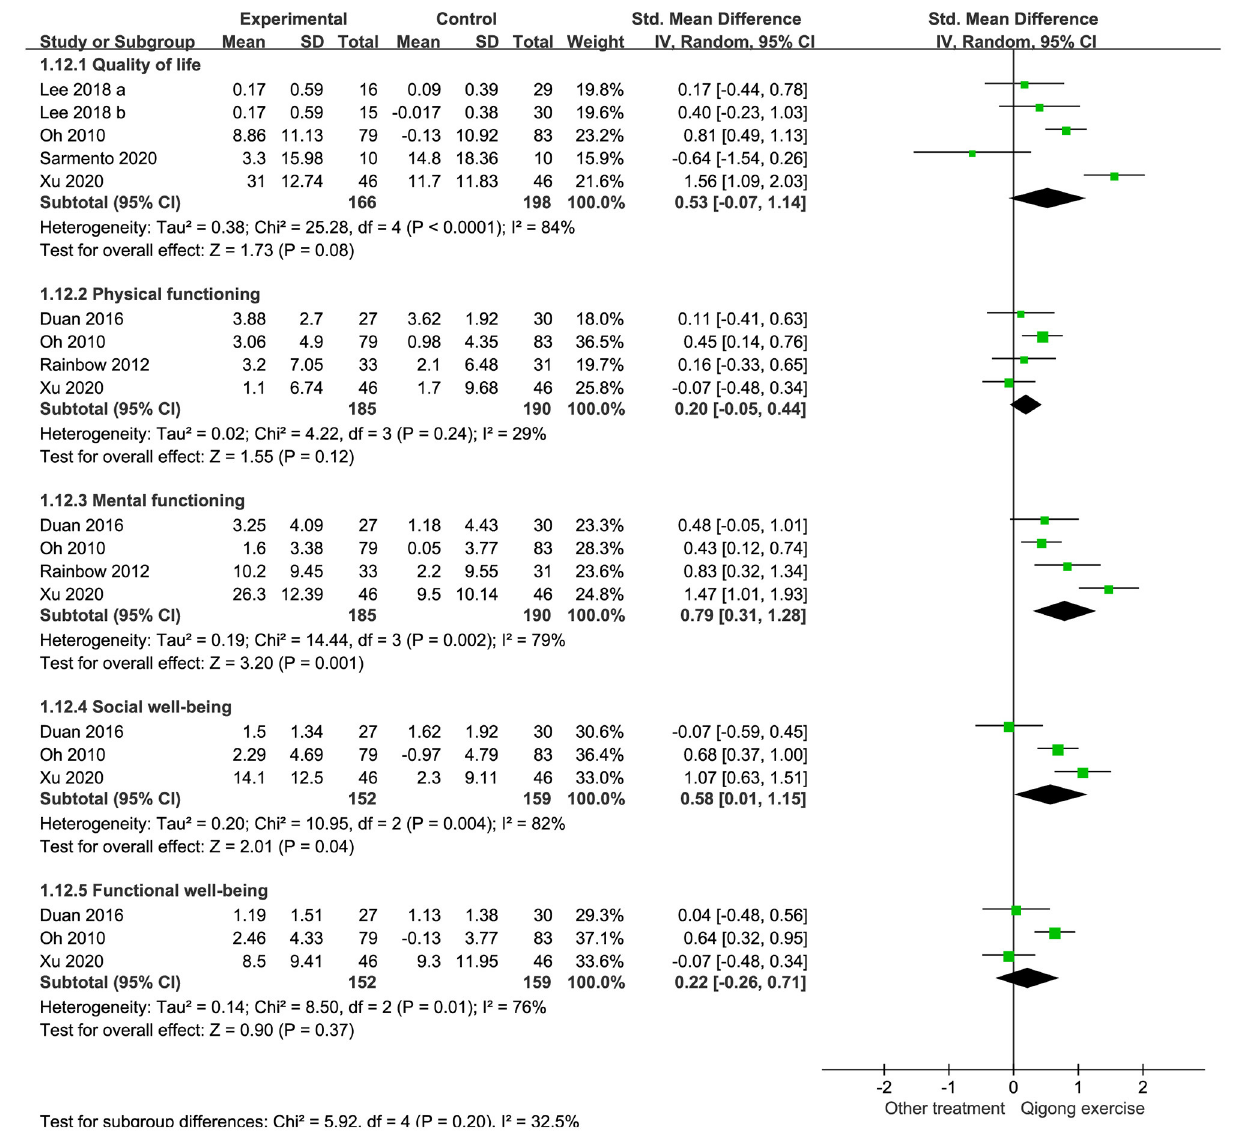
FIGURE 4 | Forest plots illustrating the meta-analysis of outcomes with Qigong exercise (QE) vs. other treatments for quality of life (QOL). The outcomes analyzed were (A) QOL scales, (B) physical and mental functioning scales, and (C) social and functional well-being